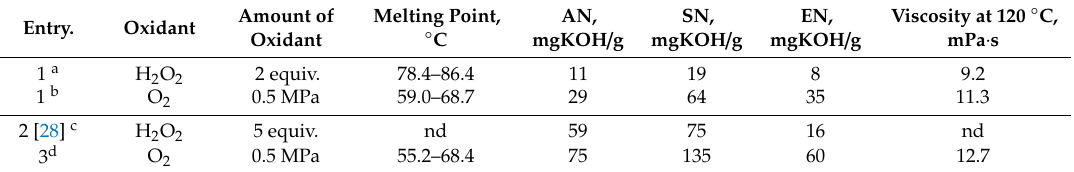
Table 8. Products of C30 + olefin oxidation using H 2 O 2 , O 2 , or both H 2 O 2 and O